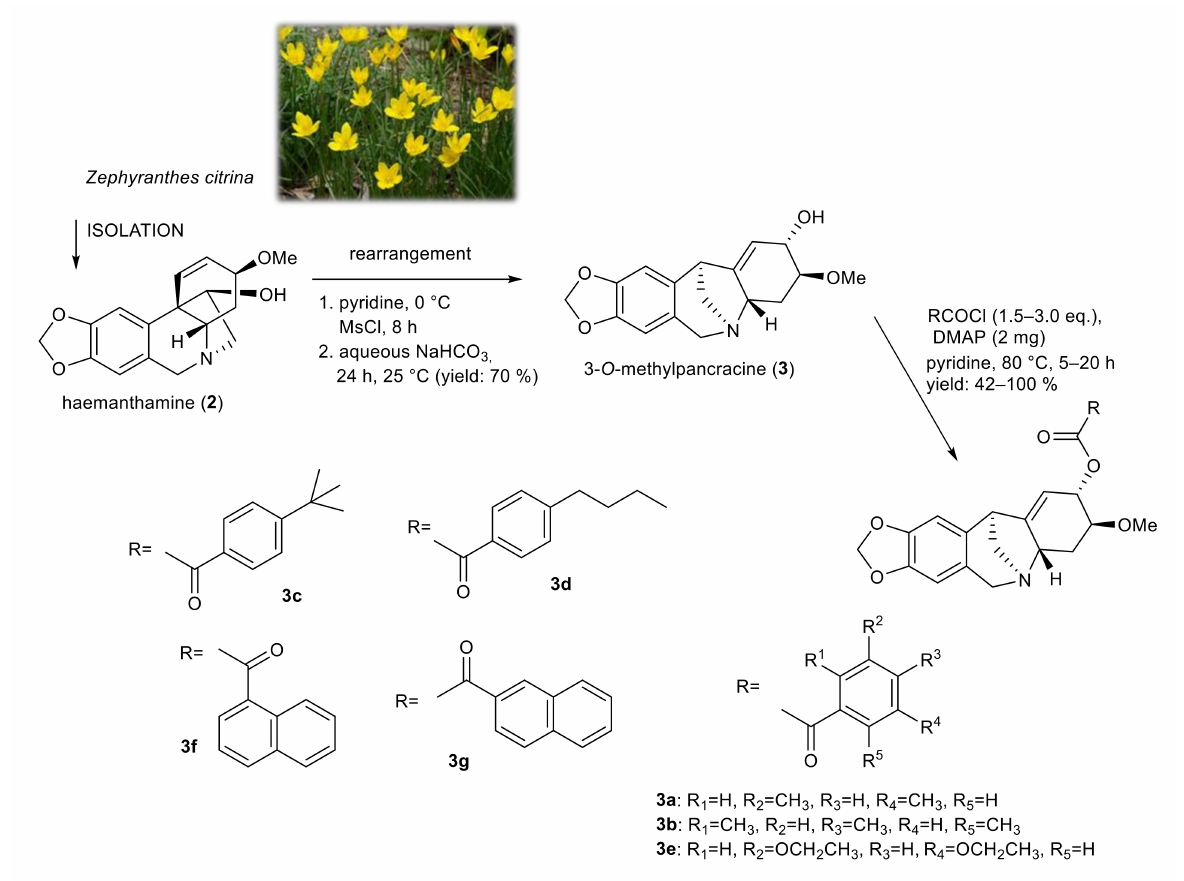
Figure 2. Chemical procedures affording 3- O -methylpancracine derivatives ( 3a – 3g